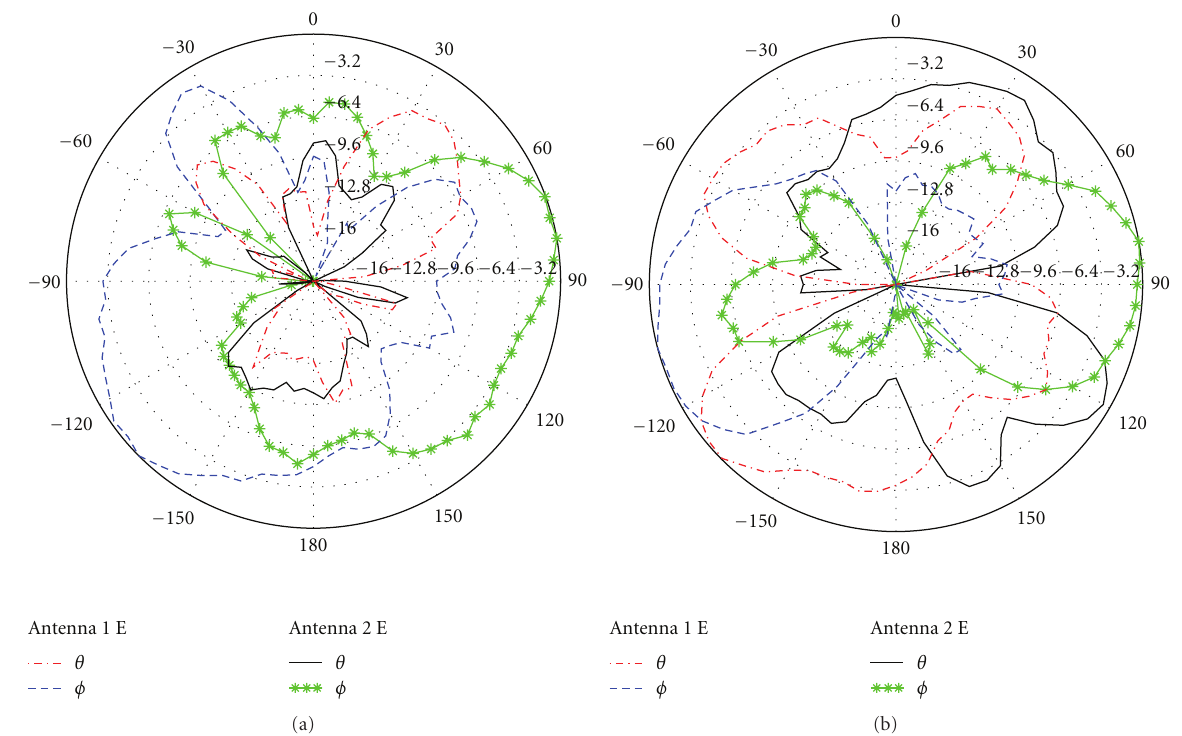
Figure 10: Measured radiation pattern at 2.5GHz. (a) The yoz plane. (b) The xoz plane.